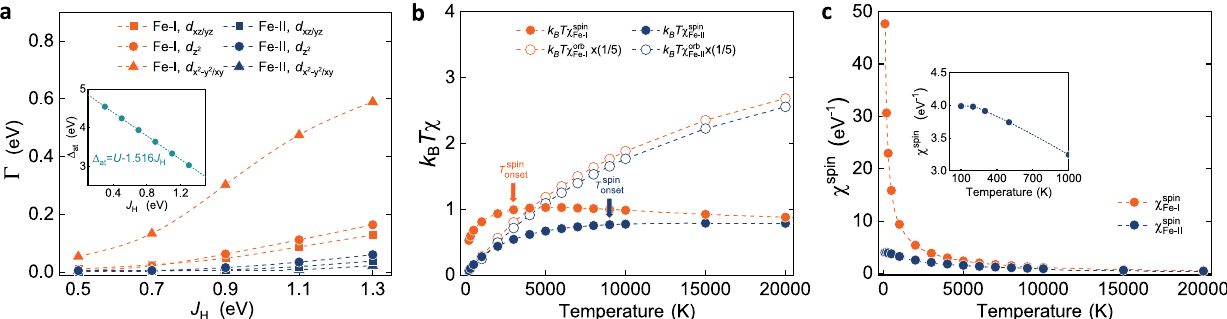
Fig. 2 Quasiparticle scattering rate Γ , local susceptibilities multiplied by temperature k B T χ and the spin susceptibilities with no factor T . a The J Γ for each orbital in Fe-I (orange) and Fe-II (blue) at T = 300 K. Inset in ( a ) shows the k B H dependence of quasiparticle scattering rate J H dependence of Δ at for a degenerate fi ve-orbital model with six electrons. b , c Temperature dependence of the susceptibilities ( b ) k B T χ spin/orb and ( c ) χ spin of Fe-I (orange) and Fe-II (blue). The fi lled and open symbols refer to the spin and orbital susceptibility, respectively. Two arrows in ( b ) indicate the onset temperature of spin screening below which χ spin deviates from the Curie law of free local moment. The inset in ( c ) is an enlarged view of χ spin in the low-temperature Fe (cid:1) II